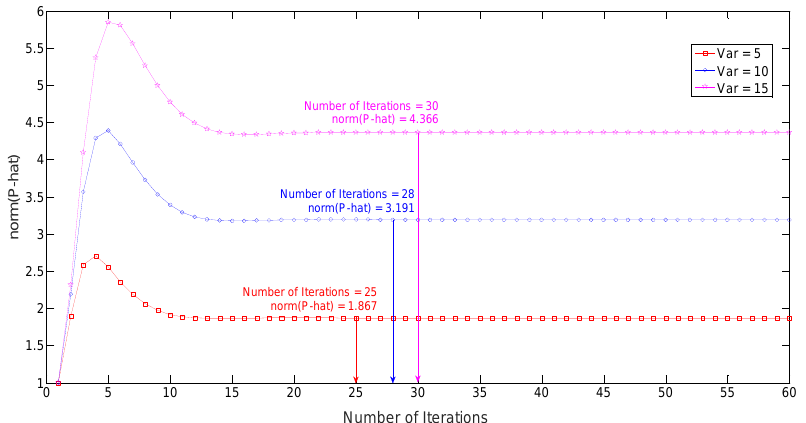
Figure 3. The learning curves of the Kalman gain of the stable convergence in the light of the norm of the estimation error covariance with the iteration parameter.